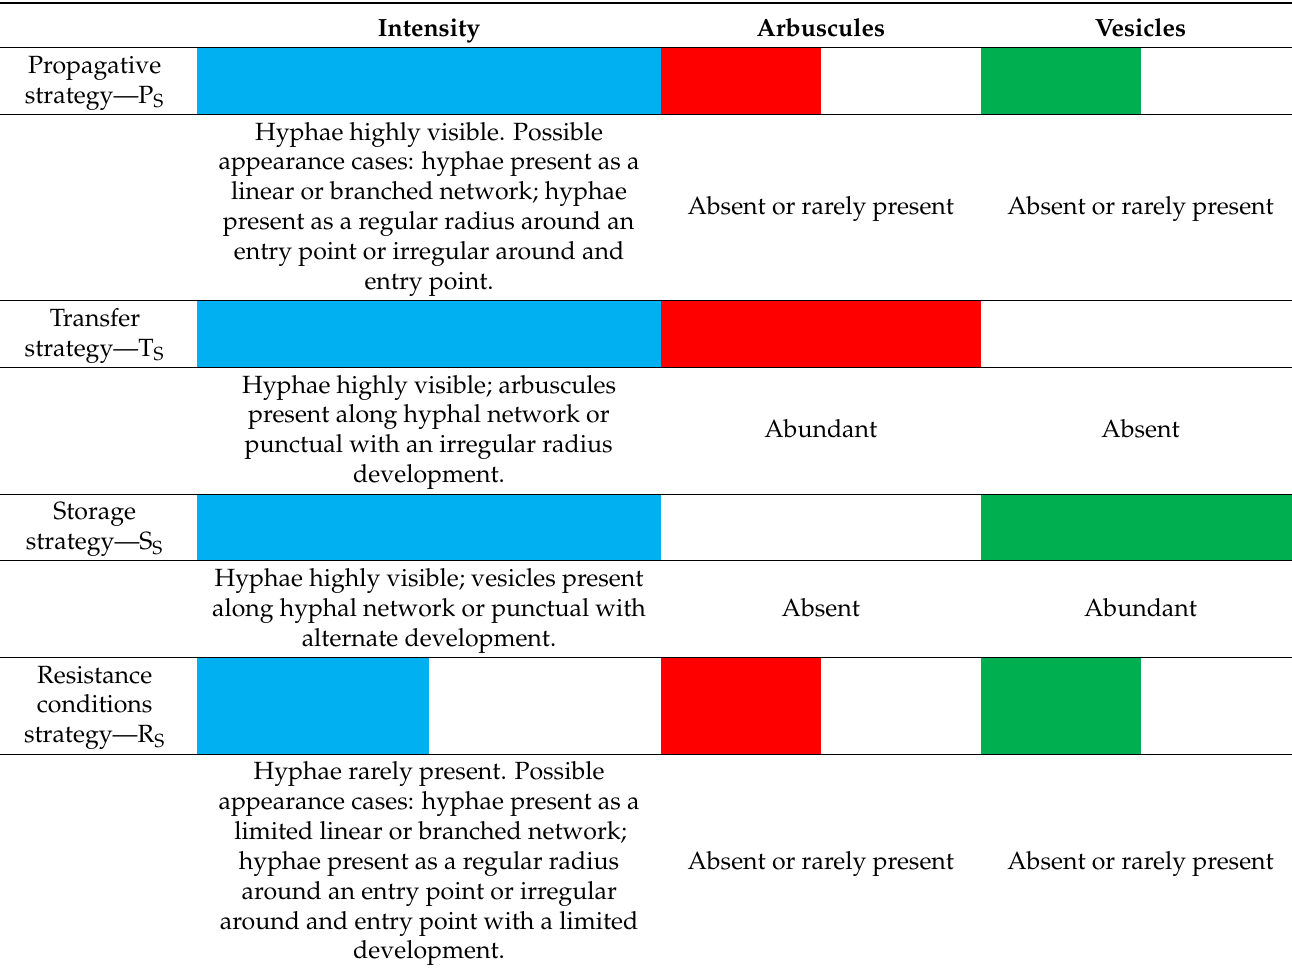
Table 2. Mycorrhizal colonization strategies and the guide to fungal patterns in roots of F. rubra